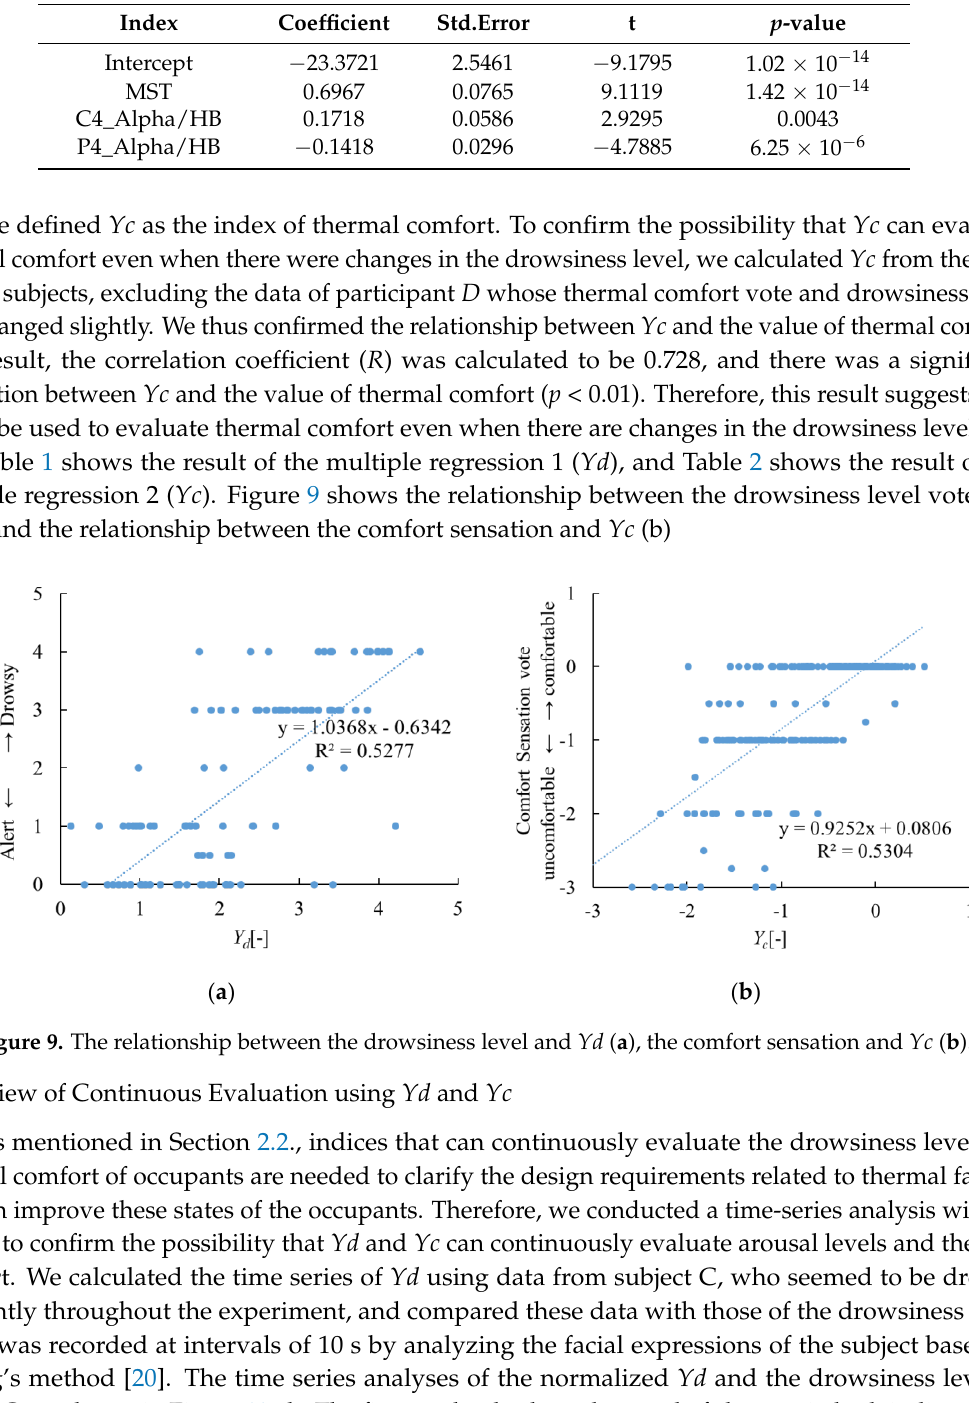
Table 2. Result of multiple regression 2 ( Yc ).